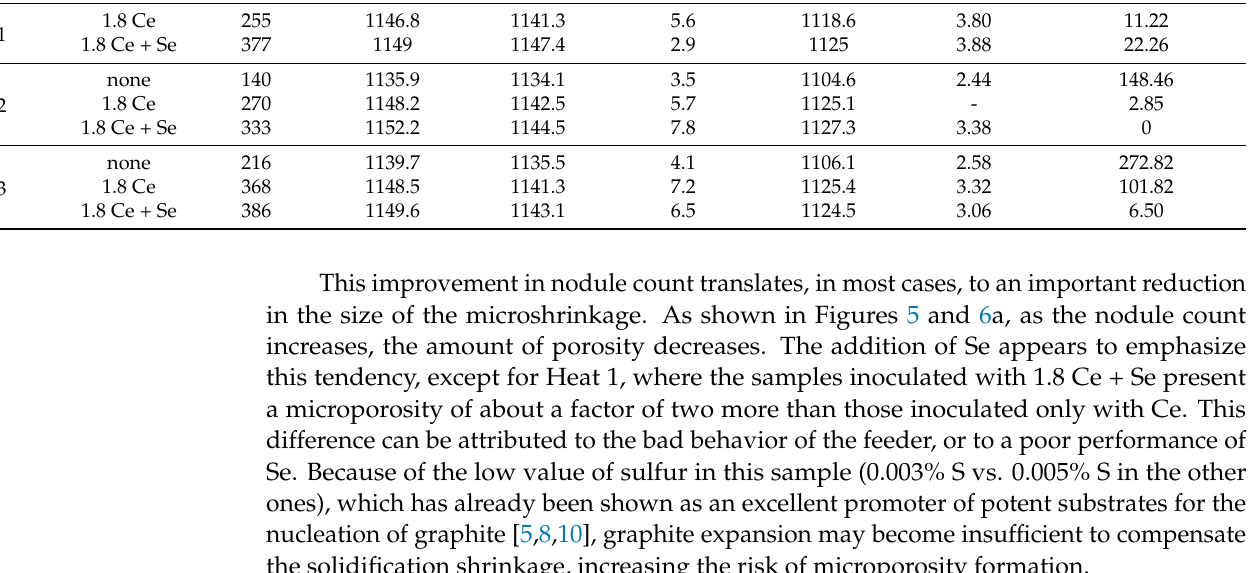
Table 4. Experimental results showing the effect of inoculant and Se additions on formation of microshrinkage and cooling curve parameters. Inoc. Heat